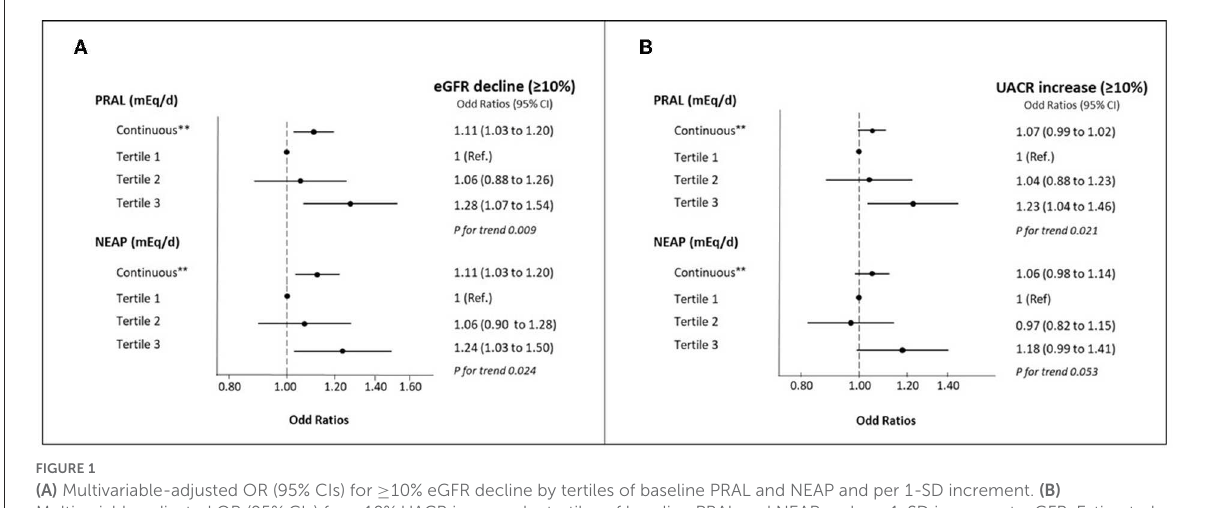
FIGURE1 (A) Multivariable-adjusted OR (95% CIs) for ≥ 10% eGFR decline by tertiles of baseline PRAL and NEAP and per 1-SD increment. (B) Multivariable-adjusted OR (95% CIs) for ≥ 10% UACR increase by tertiles of baseline PRAL and NEAP and per 1-SD increment. eGFR, Estimated glomerular filtration rate; NEAP, Net Endogenous Acid Production; T, tertile; PRAL, Potential Renal Acid Load; UACR, Urine albumin/creatinine ratio. Percentage of participants with eGFR decline ( > 10%): tertile 1 of PRAL ( n = 296; % = 15.1), tertile 2 of PRAL ( n = 304; % = 15.5), tertile 3 of PRAL ( n = 346; % = 17.7); tertile 1 of NEAP ( n = 297; % = 15.2), tertile 2 of NEAP ( n = 312; % = 15.9). tertile 3 of NEAP ( n = 337; % = 17.2). Percentage of participants with UACR increase ( > 10%): tertile 1 of PRAL ( n = 539; % = 44.4), tertile 2 of PRAL ( n = 547; % = 45.1), tertile 3 of PRAL ( n = 597; % = 49.2); tertile 1 of NEAP ( n = 550; % = 45.3), tertile 2 of NEAP ( n = 539; % = 44.4), tertile 3 of NEAP ( n = 594; % = 49.0). All models were adjusted for age (years), sex, participating center (categorized into quartiles by number of participants), intervention group (treatment/control), body mass index (kg/m 2 ), smoking habits (never, current or former smoker), educational level (primary, secondary education or graduate), leisure-time physical activity (METS/min/week in tertiles), diabetes prevalence (yes/no), hypertension prevalence (yes/no)